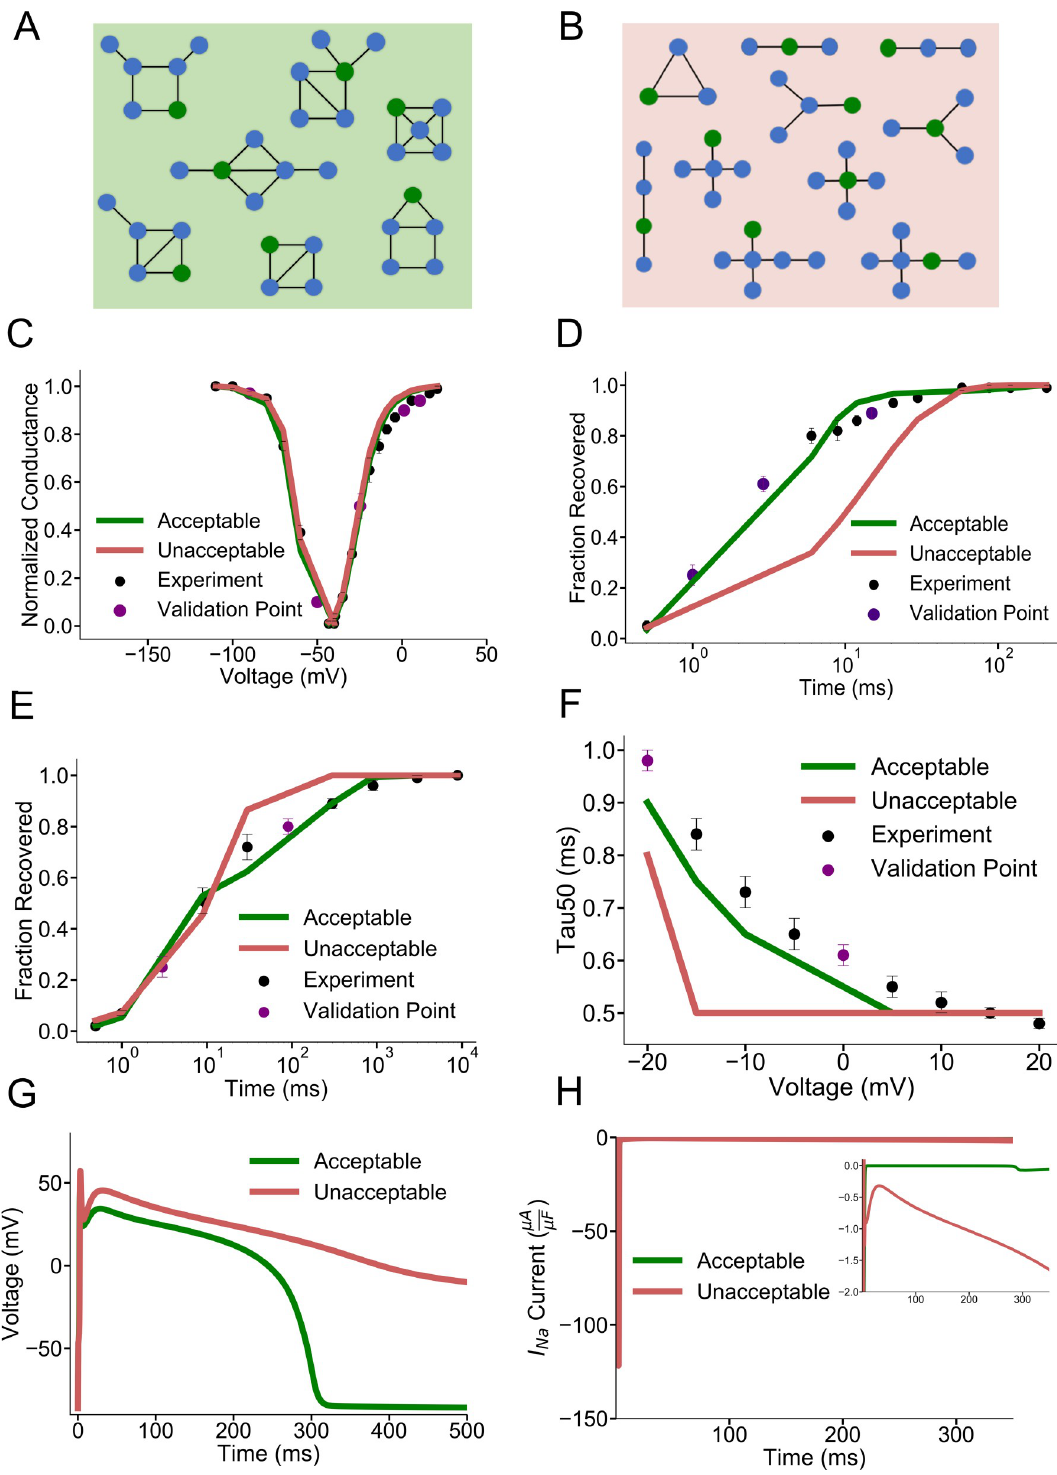
Fig 3. Identification of possible model structures for the I Na HEK dataset A) Representative acceptable model topologies of the more complex HEK I Na dataset. Topologies have at least 8 free rate constants. B) Representative unacceptable model topologies. Topologies have fewer than 8 free rate constants or are sparsely connected. C) Representative acceptable and unacceptable model fits to steady state activation and inactivation D) Representative fits to fast recovery from inactivation E) Representative fits to